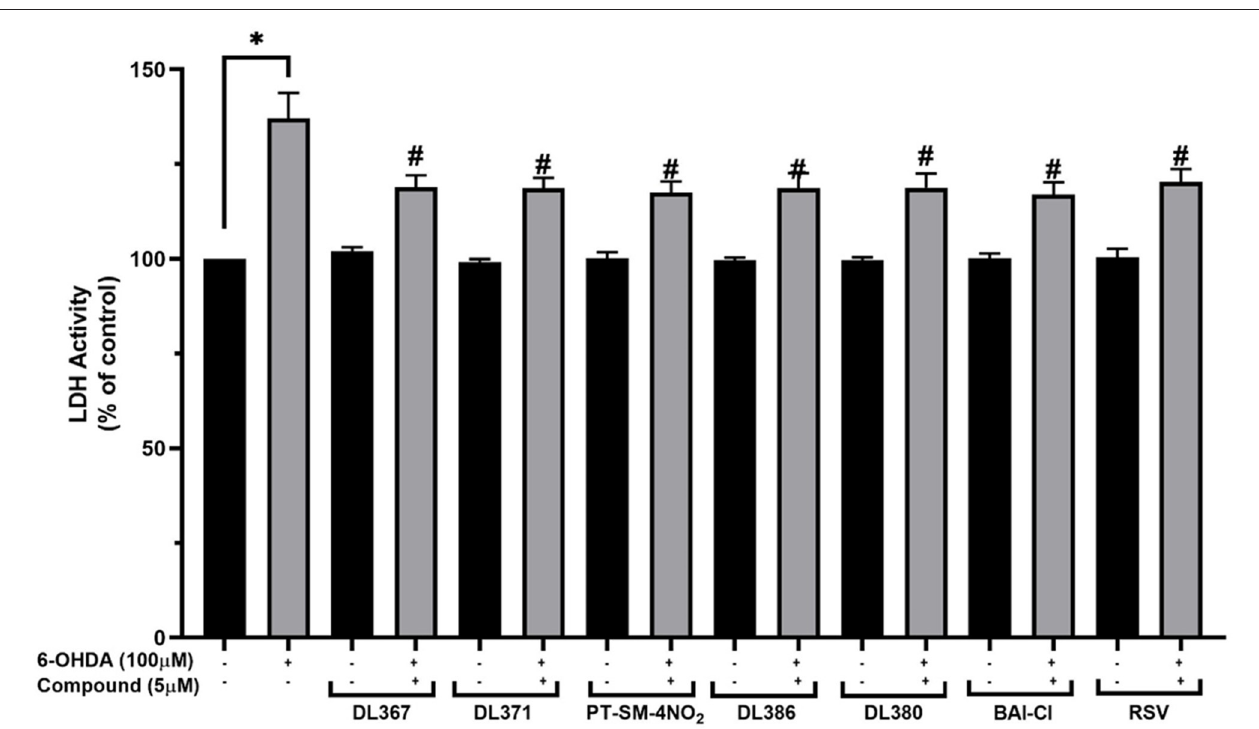
FIGURE 4 | Measurement of lactate dehydrogenase (LDH) levels in culture medium. The SH-SY5Y cells were incubated with 5 µ M of bis-sulfonamides or resveratrol for 3h followed by 100 µ M of 6-OHDA for 24h. Then, the culture medium was collected and determined by LDH assay. The data are expressed as mean ± SEM, and statistical analysis was performed using one-way ANOVA. * P < 0.05 compared with the control cells; # P < 0.05 compared with the 6-OHDA.